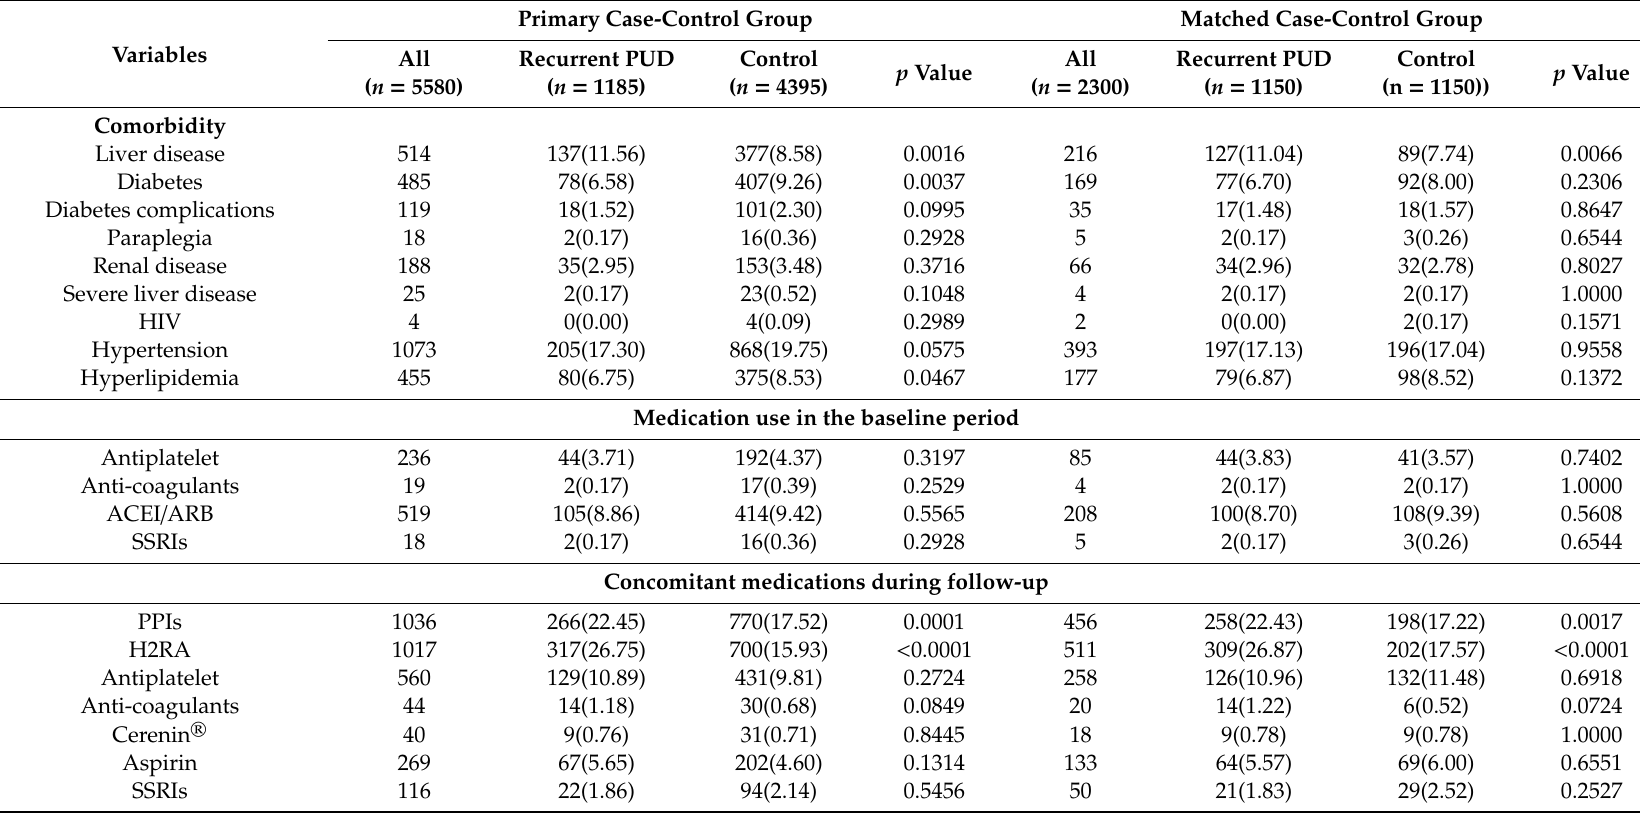
Abbreviations: PUD, peptic ulcer disease; NSAIDs, non-steroidal anti-inflammatory drugs; cDDD, cumulative defined daily doses; HP, Helicobacter pylori ; HIV, human immunodeficiency virus; ACEI / ARB, angiotension-converting enzyme inhibitor / angiotension receptor blocker, PPIs, proton pump inhibitors; H2RA, H2 receptor antagonists; Cerenin ® , Ginkgo biloba leaves extract; SSRIs, selective serotonin reuptake inhibitors; SD (standard